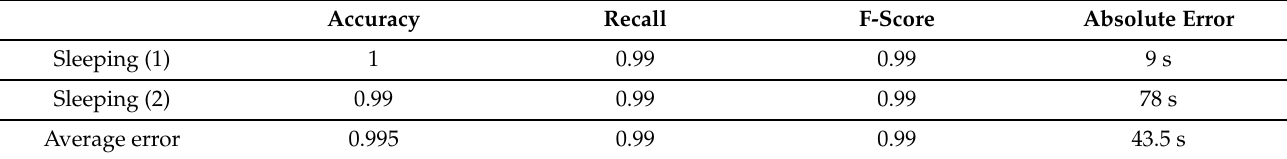
Table 3. F-score comparison between real and simulated activities on 4 November 2010.